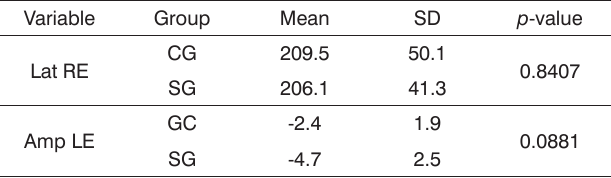
Table 7. Descriptive statistics of the mean, standard deviation (SD), minimum value, maximum value and p -value of the MMNd latency and amplitude variables of the RE.